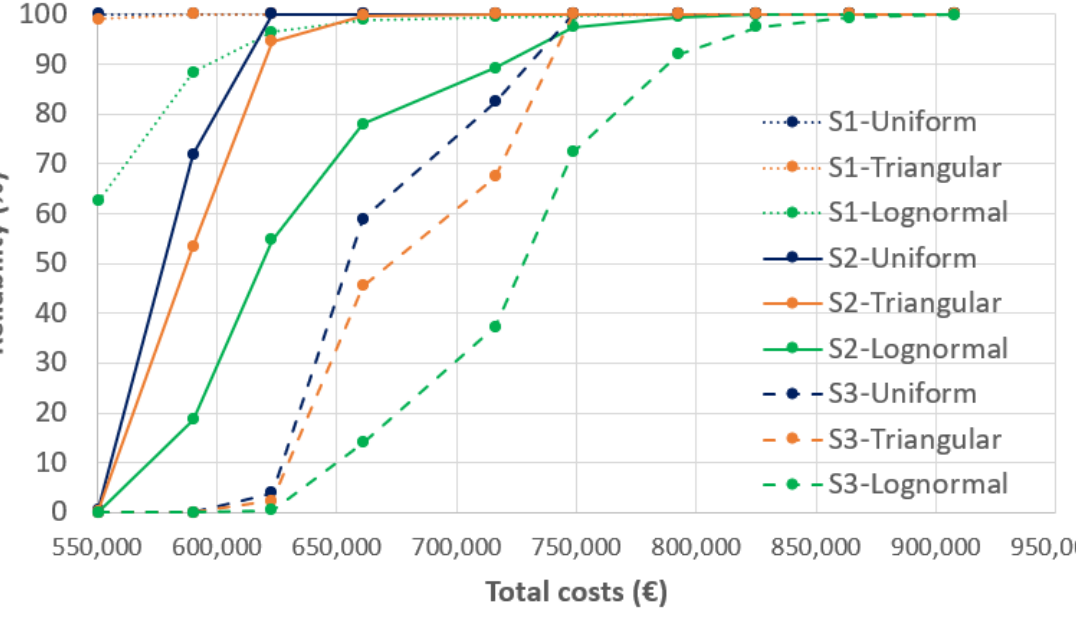
Figure 10. Optimal solutions evaluated in terms of costs and